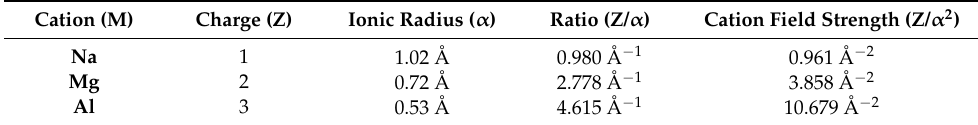
Table 2. Ratio between charge, ionic radius, and cation field strength in Na, Mg, and Al [17]. Cation (M) Charge (Z) Ionic Radius ( α ) Ratio (Z/ α ) Cation Field Strength (Z/ α 2 ) Na 1 1.02 Å 0.980 Å − 1 0.961 Å − 2 Mg 2 0.72 Å 2.778 Å − 1 3.858 Å − 2 Al 3 0.53 Å 4.615 Å − 1 10.679 Å −